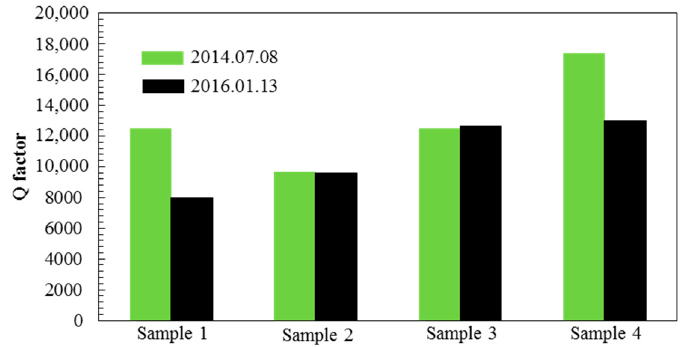
Figure 13. The Q value test of 4 samples with an interval of 1.5 years under the same condition. Sample 1 and sample 4 decreased a little while sample 2 and sample 3 basically unchanged.